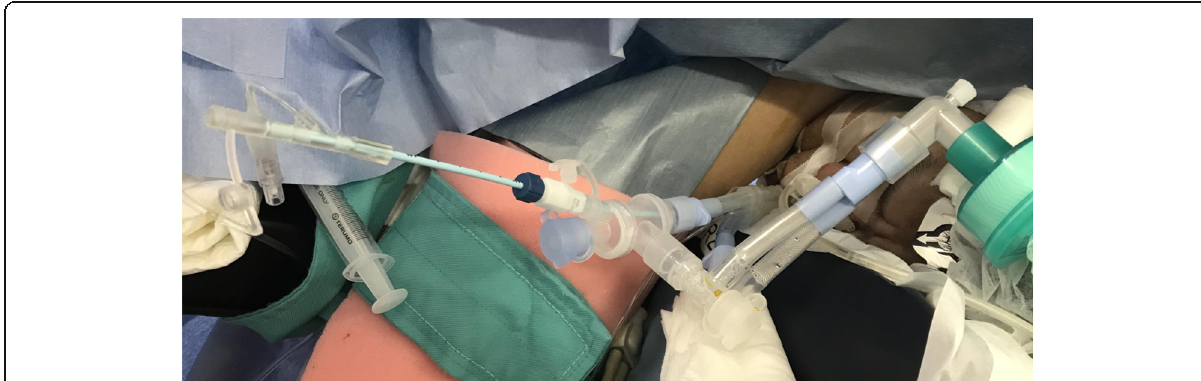
Fig. 3 Intraoperative use of the left-sided double lumen tube and bronchial blocker. The bronchial blocker (BB) was inserted through the tracheal lumen of the left-sided double lumen tube (DLT). The left lung was ventilated through the bronchial lumen of the DLT, and the right middle and lower lobes were ventilated through the tracheal lumen of the DLT. The right upper lobe was partially blocked with the BB